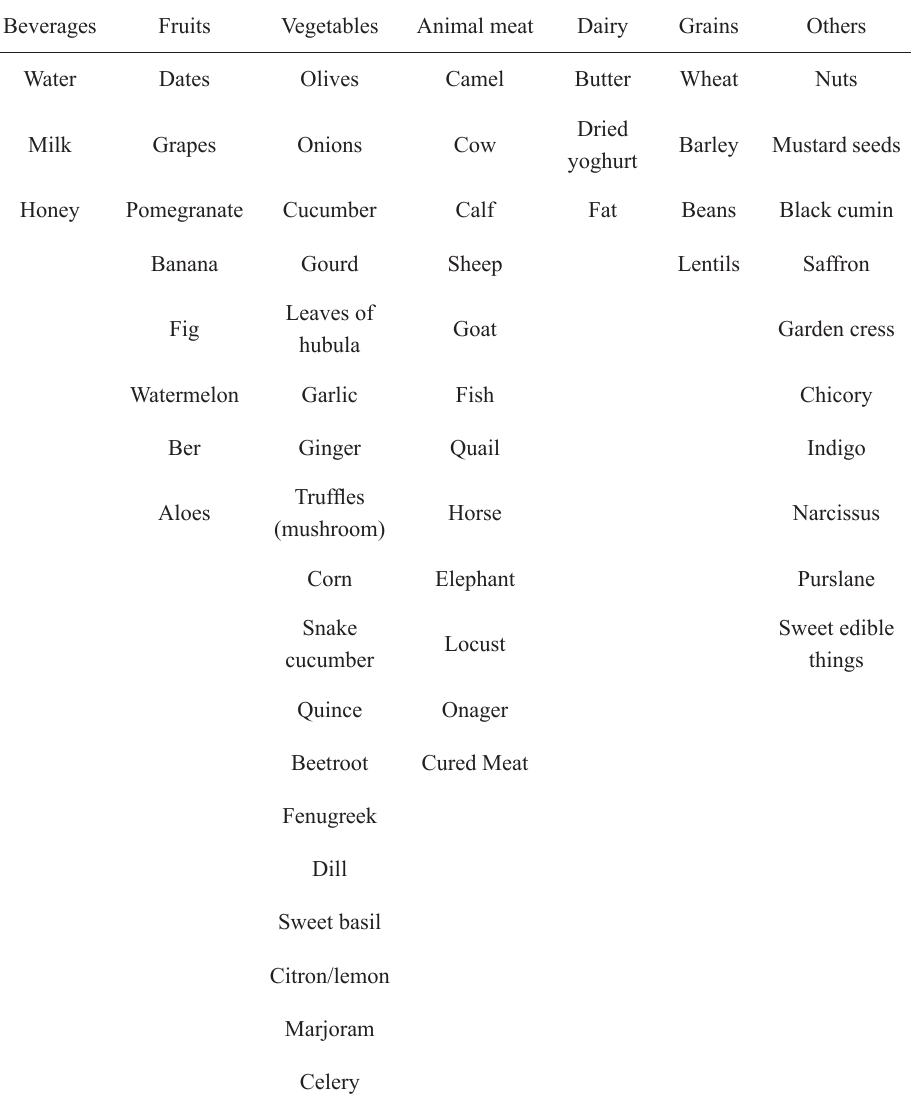
Table 1. Categorization of foods in food groups based on Holy Quran and